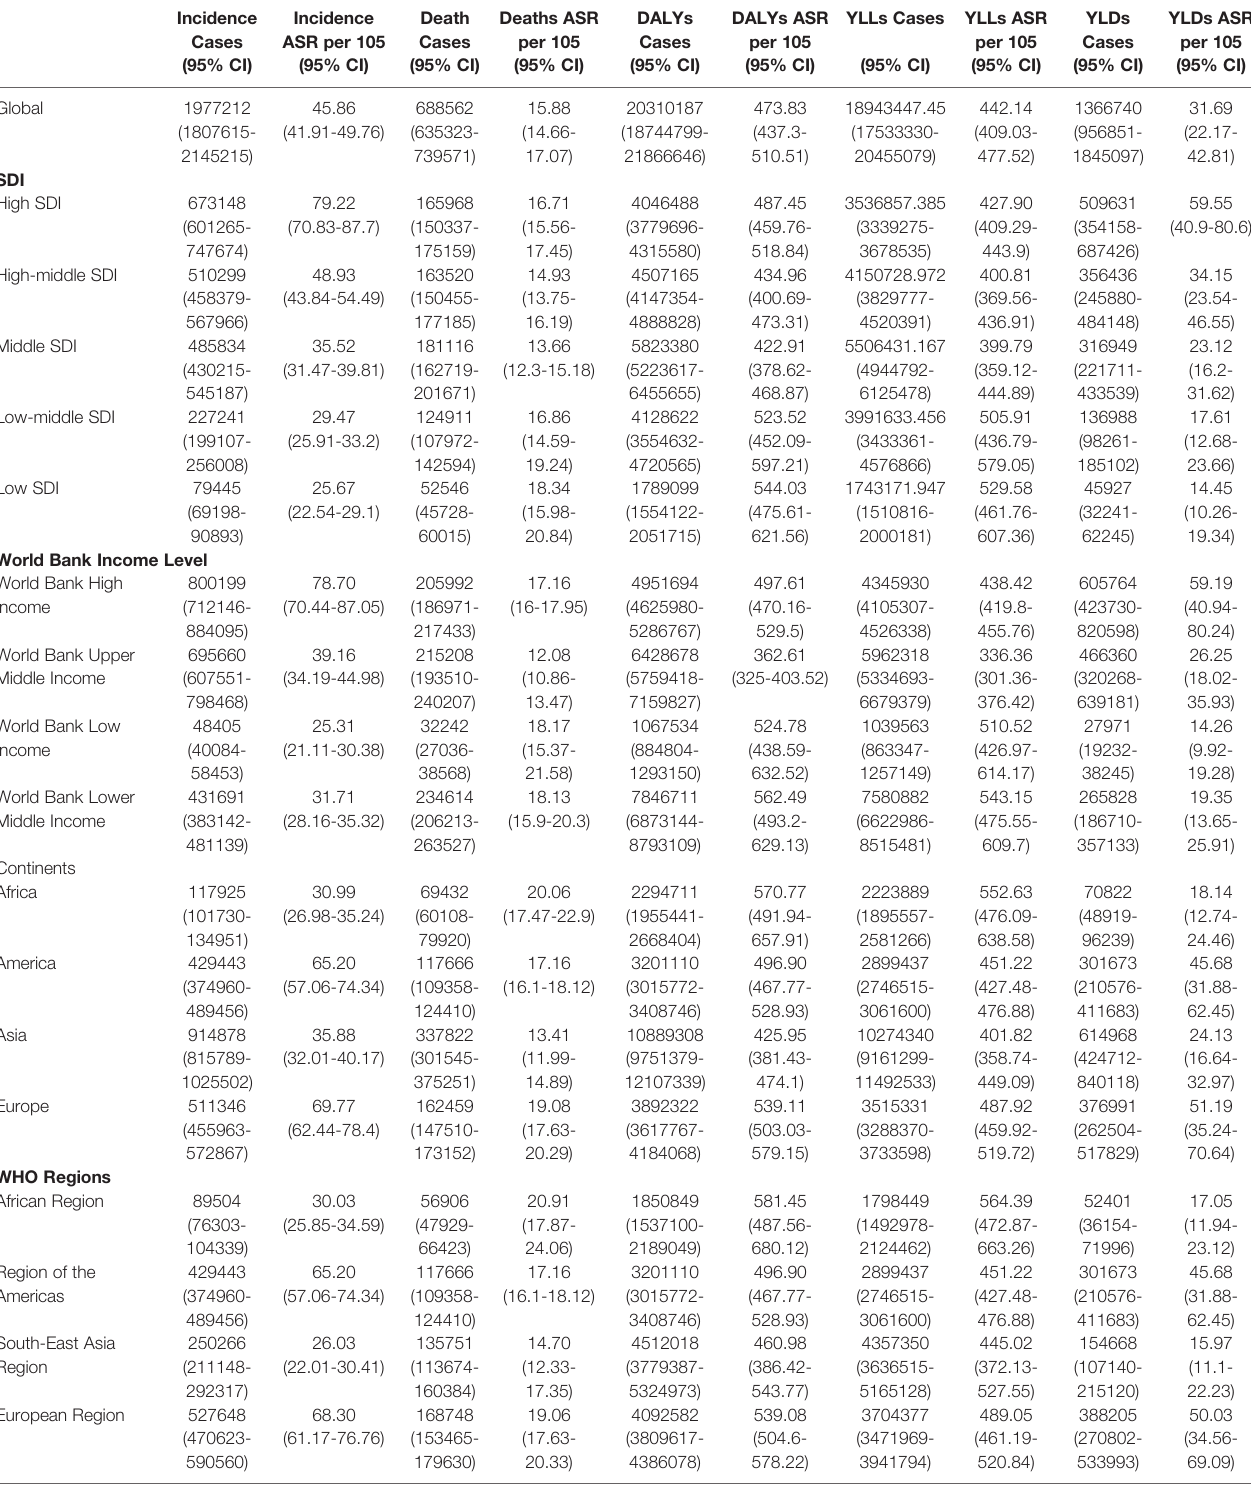
TABLE 1 | Breast cancer incidence cases, age-standardized incidence rate, deaths, age-standardized mortality rates, DALYs, age-standardized DALY rates, YLLs, age-standardized YLLs rates, YLDs, and age-standardized YLDs rates in